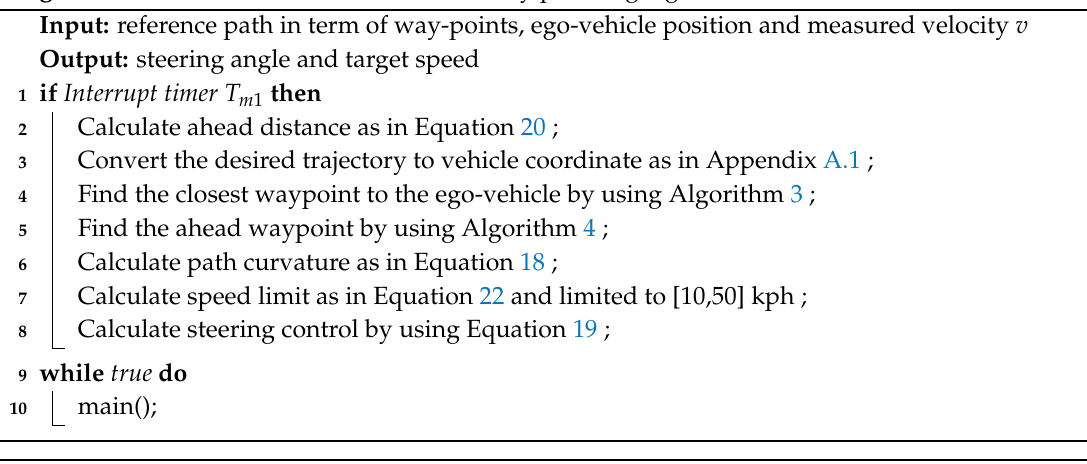
Algorithm 3: Find the closest waypoint to the